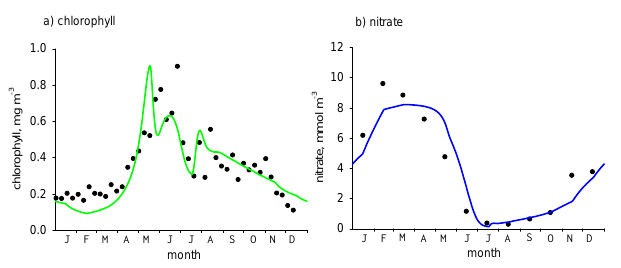
Figure 12. Predicted state variables and fluxes for the station BIO- TRANS simulation: (a) P , Z and D and (b) phytoplankton growth, grazing and non-grazing mortality.